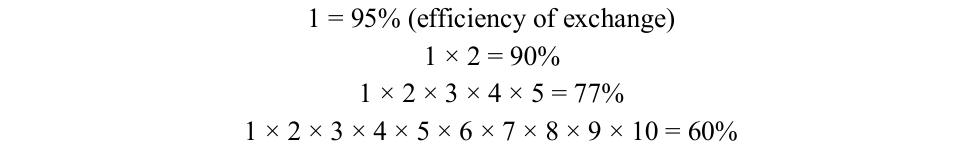
Table 3. Two metabolons are shown, each consisting of five enzymes; each metabolon (compartment) is 95%